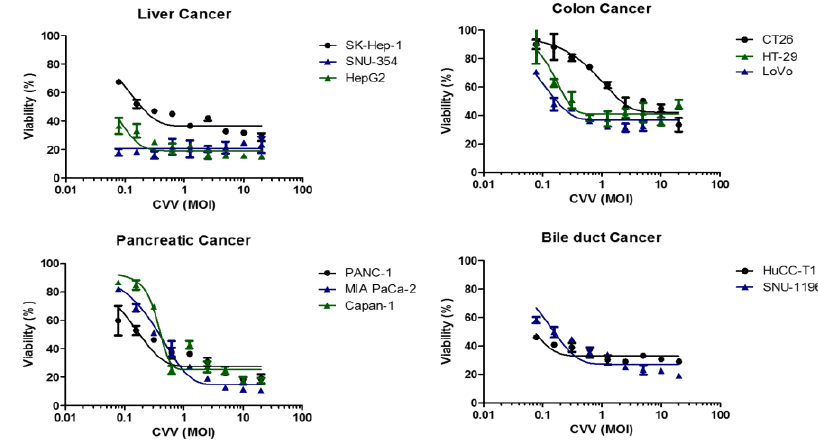
Figure 1. Oncolytic activity of the cancer-favoring oncolytic vaccinia virus (CVV) in different type of cancer cell lines. The viability (%) of four different cancer types (liver, colon, pancreas, bile duct) against the CVV at different multiplicity of infection (MOI).